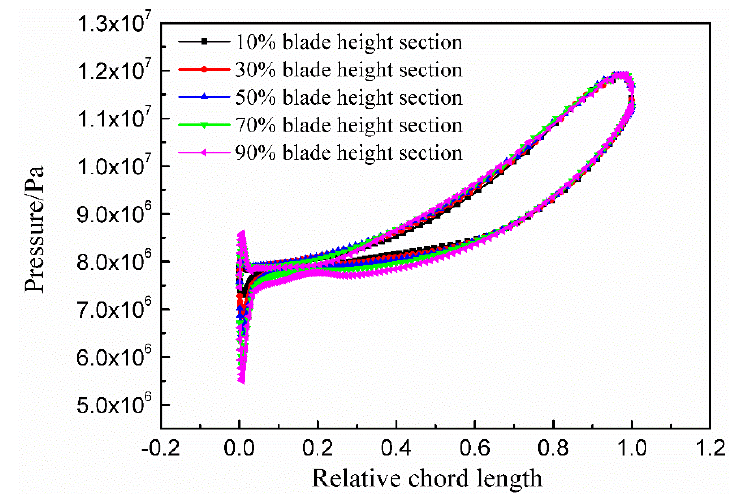
Figure 17. The pressure curves of the blade surface with different blade high cross sections.